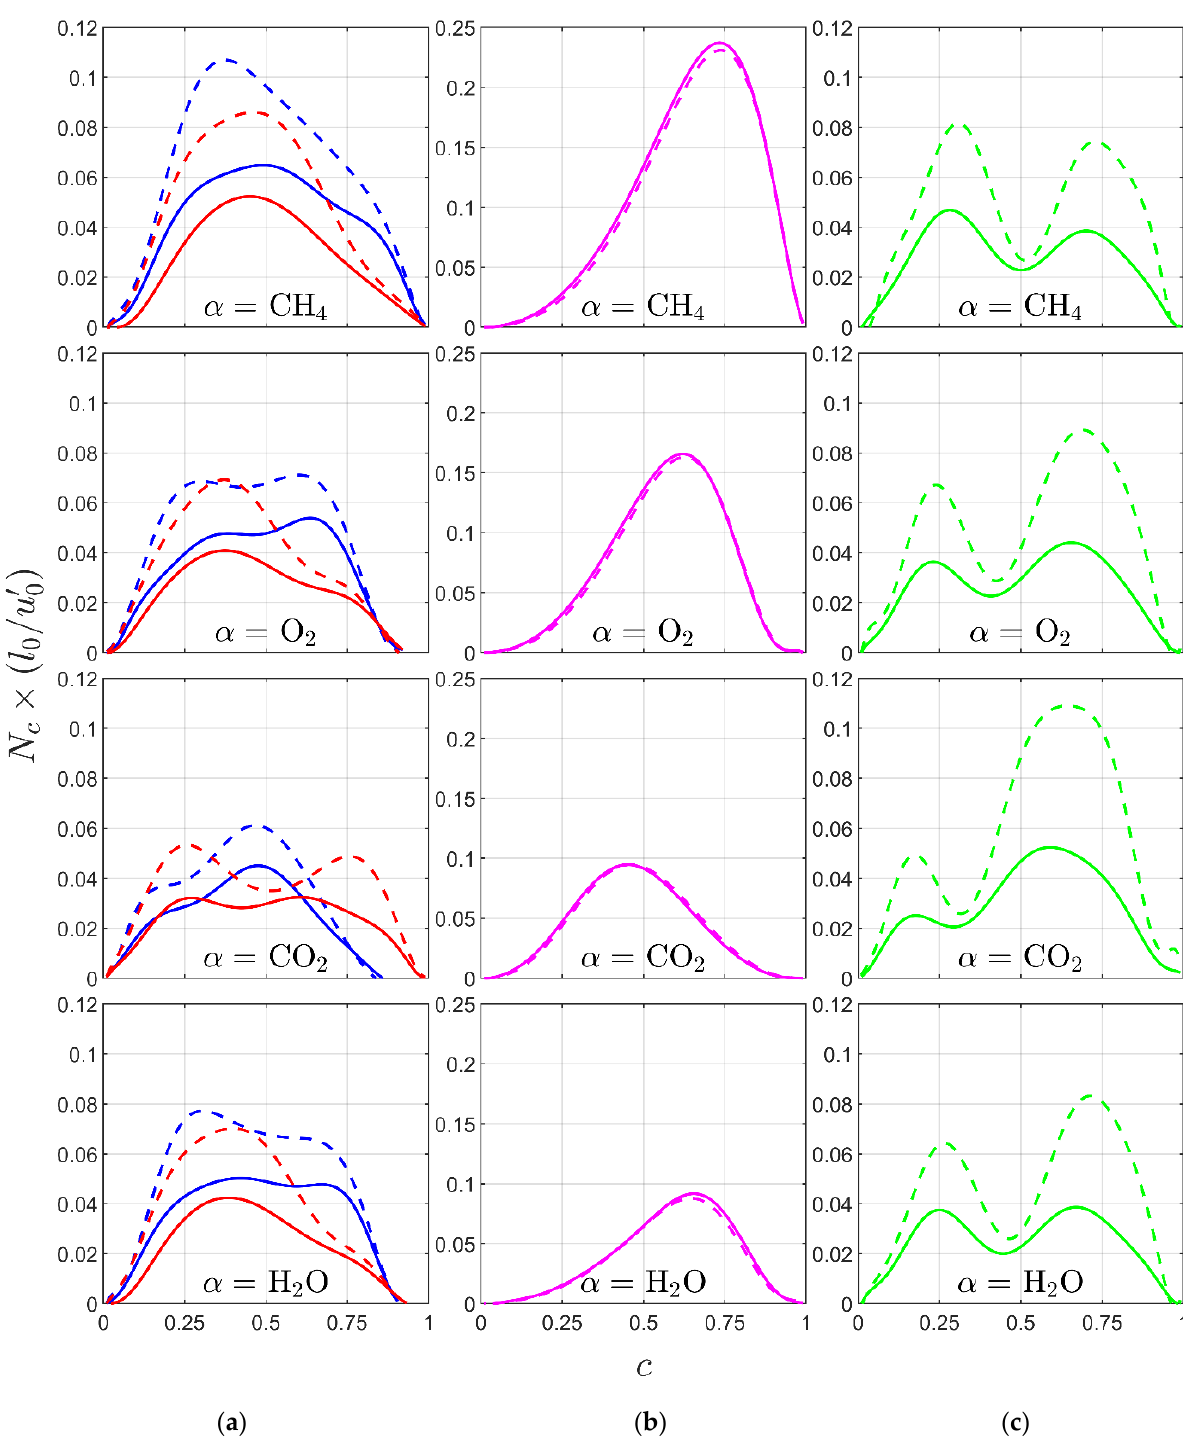
Figure 5. Profiles of the mean values of the normalised SDR 𝑁 𝑐 × 𝑙 0 /𝑢 0′ conditioned upon 𝑐 for different definitions of reaction progress variable 𝑐 for ( a ) MILD combustion (3.5% O 2 -red, 4.8% O 2 -blue), ( b ) premixed combustion (magenta), and ( c ) passive scalar mixing (green) cases considered here with 𝑢 ′ /𝑆 𝐿 = 4 (solid line) and 𝑢 ′ /𝑆 𝐿 = 8 (dashed line).